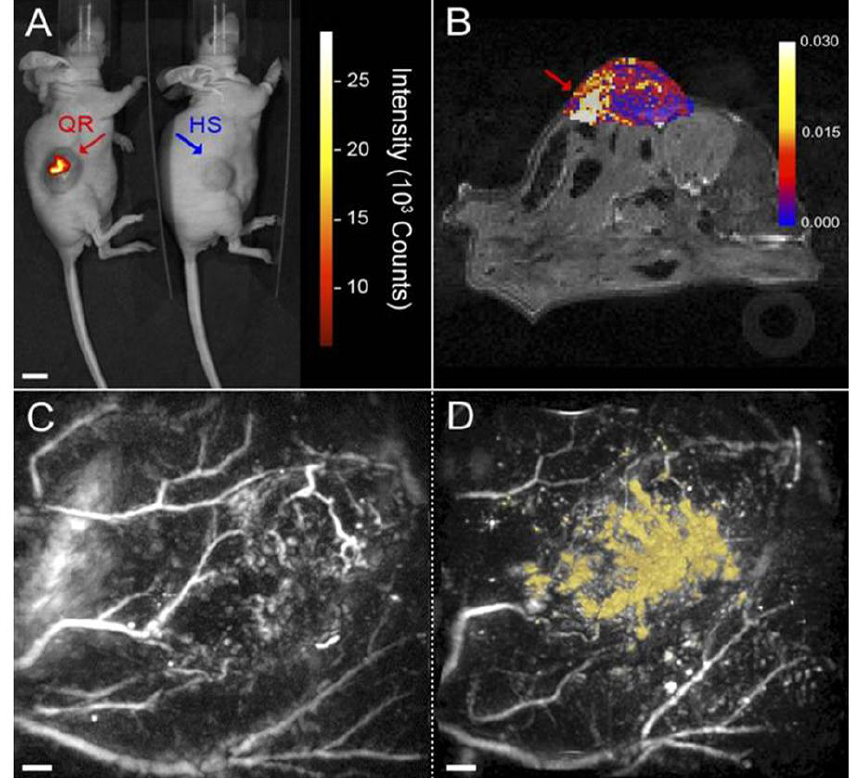
Figure 5. Multimodal in vivo imaging of quantum rattles (QRs): ( A ) NIR fluorescent intensity in the areas where QRs (red) and non-fluorescent hollow mesoporous silica shells (HS) control (blue); ( B ) MR image obtained following the injection of QRs; and 3D photoacoustic images of tumors acquired at 670 nm before ( C ) and after ( D ) the injection of QRs. Reproduced with permission from [191]. Copyright Proceedings of the National Academy of Sciences of the United States of America, 2015.